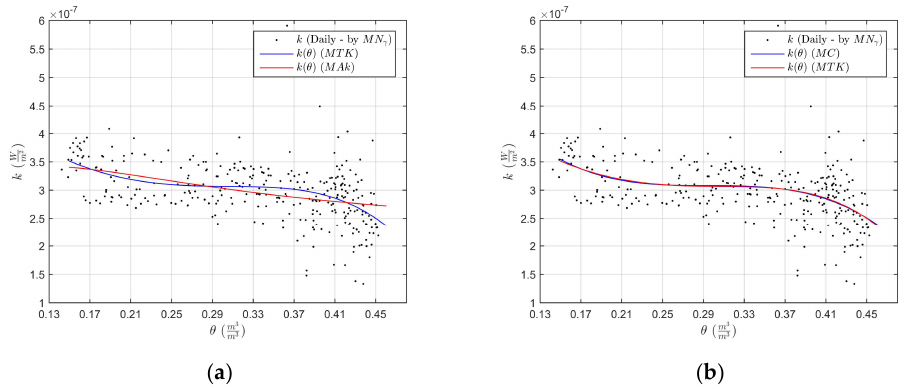
), as a function of soil water content at γ MN q (cid:7) (cid:155) (cid:156)